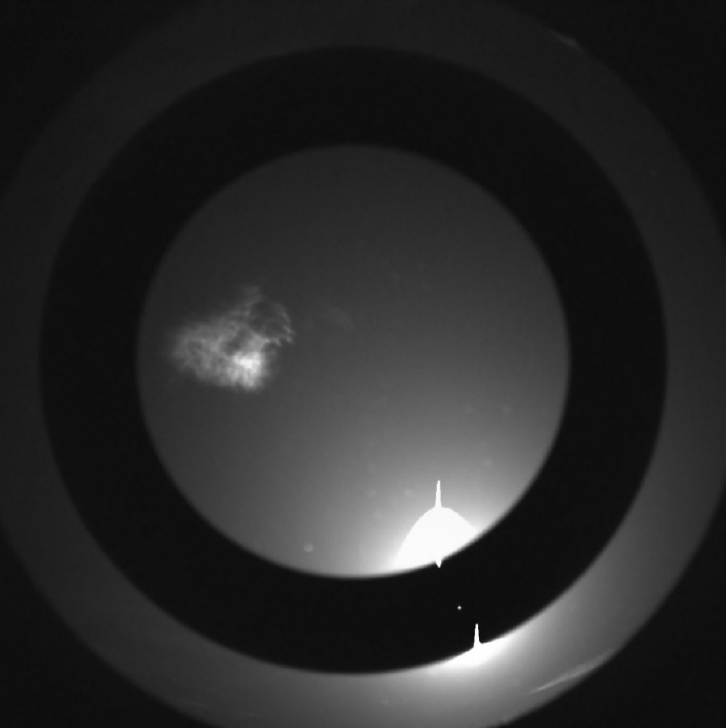
Figure 15. RDS-SkyCam image of Earth sky with new optic. Sun is visible through the ND5 filter while measurements of the sky brightness are simultaneously possible.